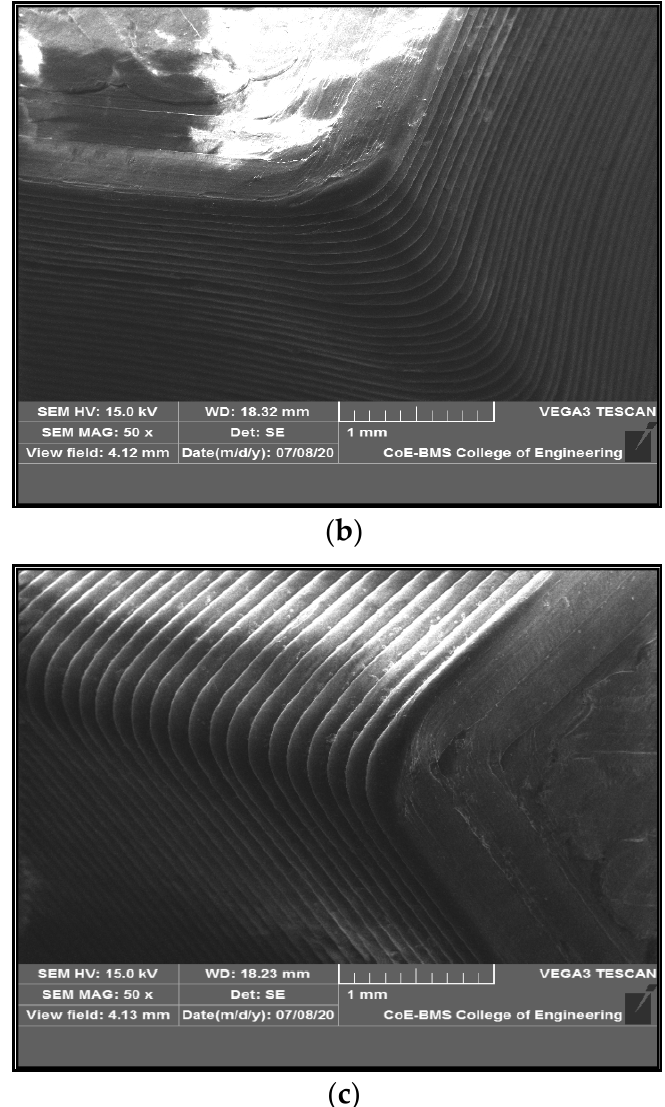
Figure 14. Isometric view of FDM-printed parts of ( a ) PC-ABS, ( b ) PC-ABS+0.4 wt % graphene, ( c ) PC-ABS + 0.8 wt % graphene.